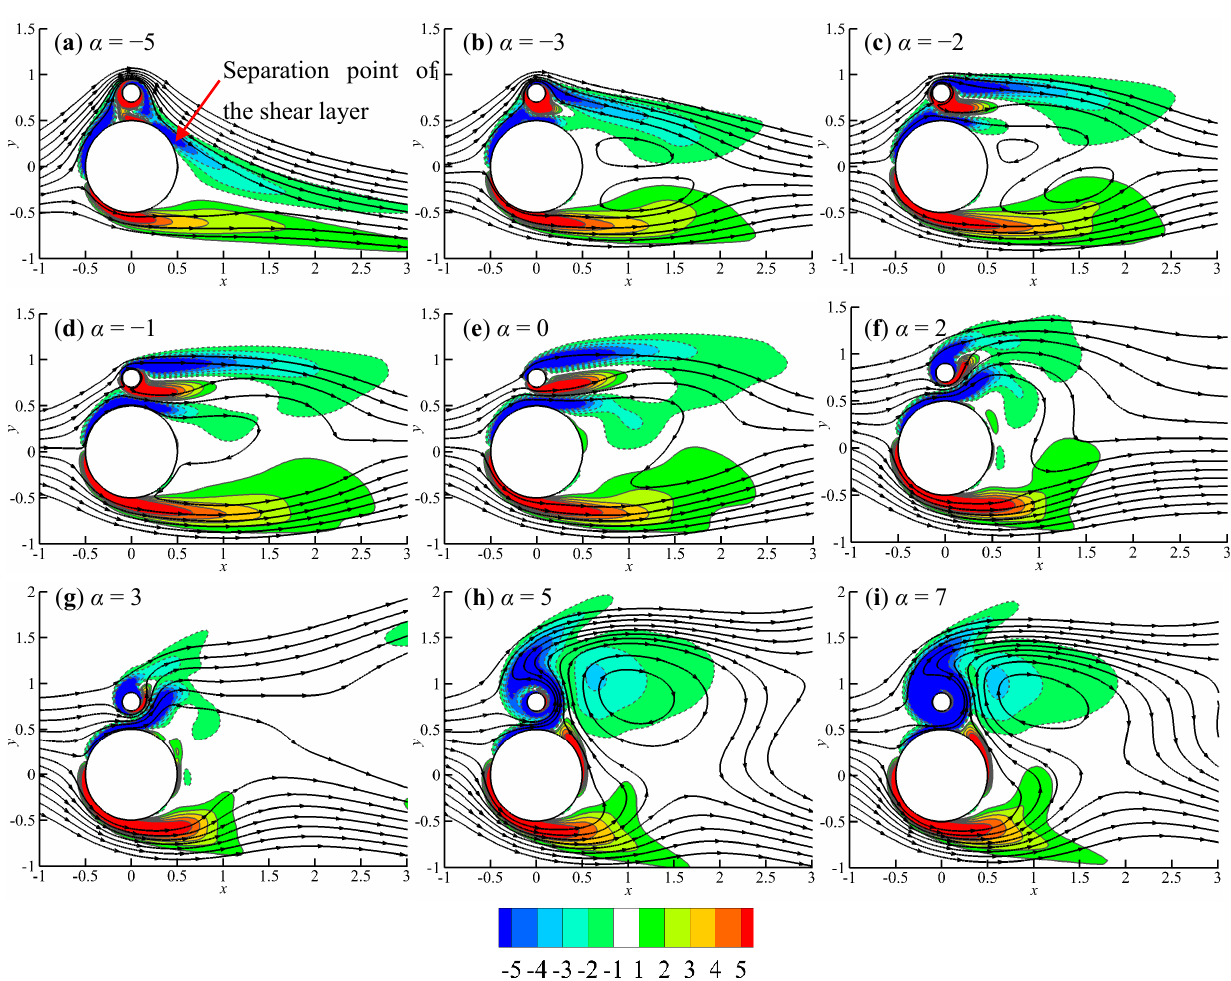
Figure 6. Streamlines and the contours of the nondimensional vorticity of the mean flow for β = 90°.